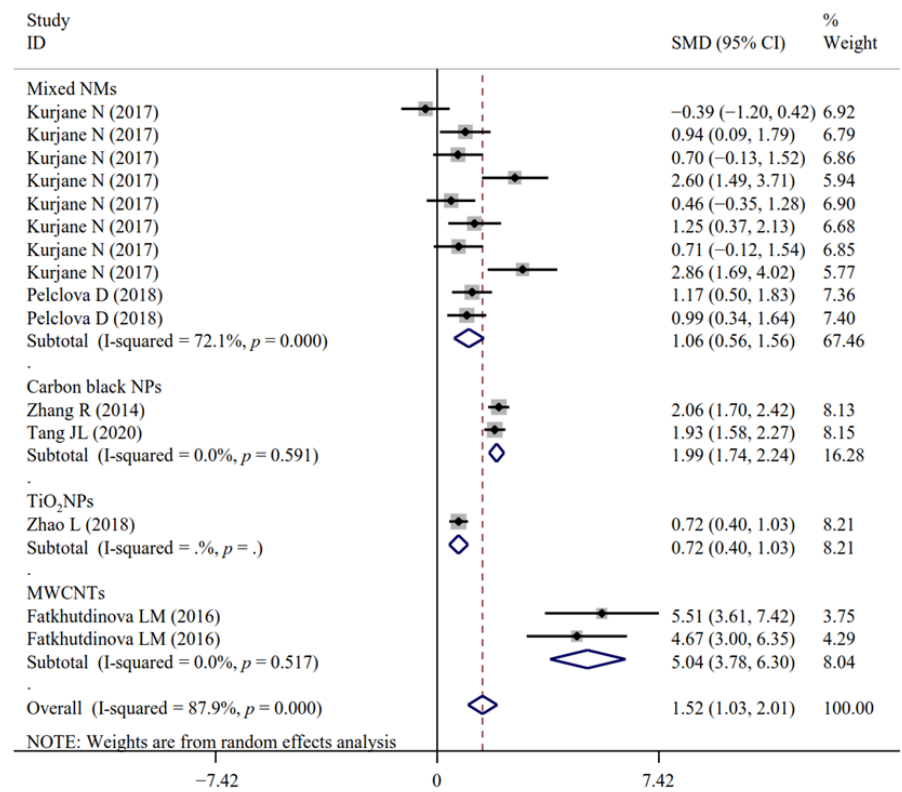
Figure 10. Forest plots assessing the effects of exposure to different NMs on the level of TNF- α compared with the non-exposed control group. NMs, nanomaterials; NPs, nanoparticles; TiO 2 NPs, titanium dioxide nanoparticles; MWCNTs, multi-walled carbon nanotubes; TNF- α , tumor necrosis factor- α ; SMD, standardized mean difference; CI, confidence interval [17,19,25,36,39,40].